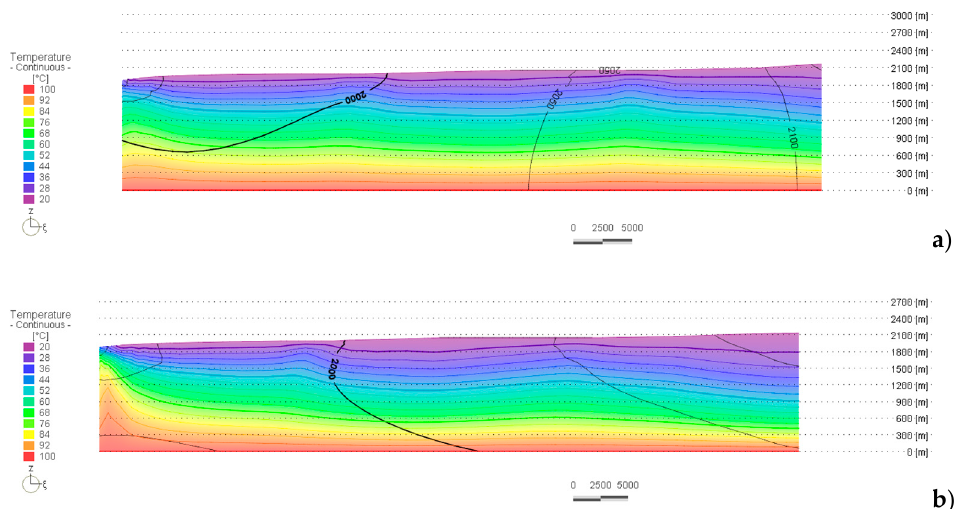
Figure 10. Cross-sections of Laja-E. Distribution of temperature and equipotential lines for: ( a ) sce- nario II (convective 1); and ( b ) scenario III (convective 2) (Table 1).